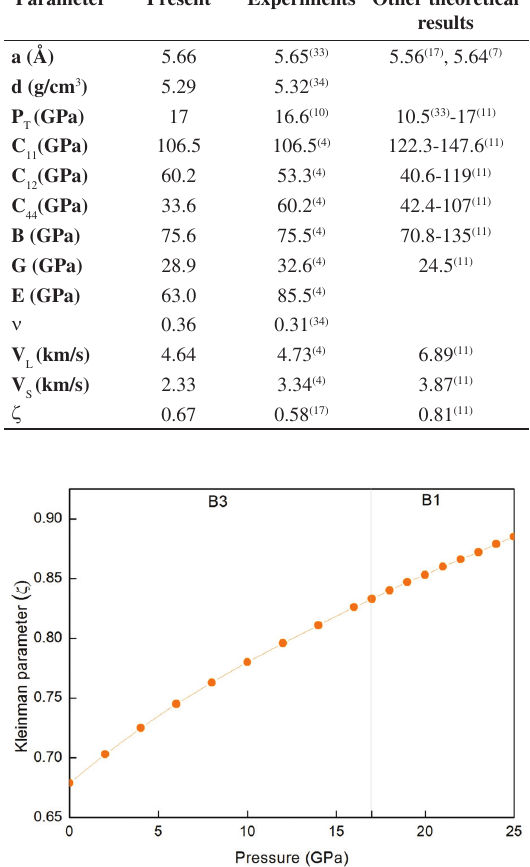
Table 1. Comparing some structural, elastic and mechanical parameters of GaAs with previous and present results. Parameter